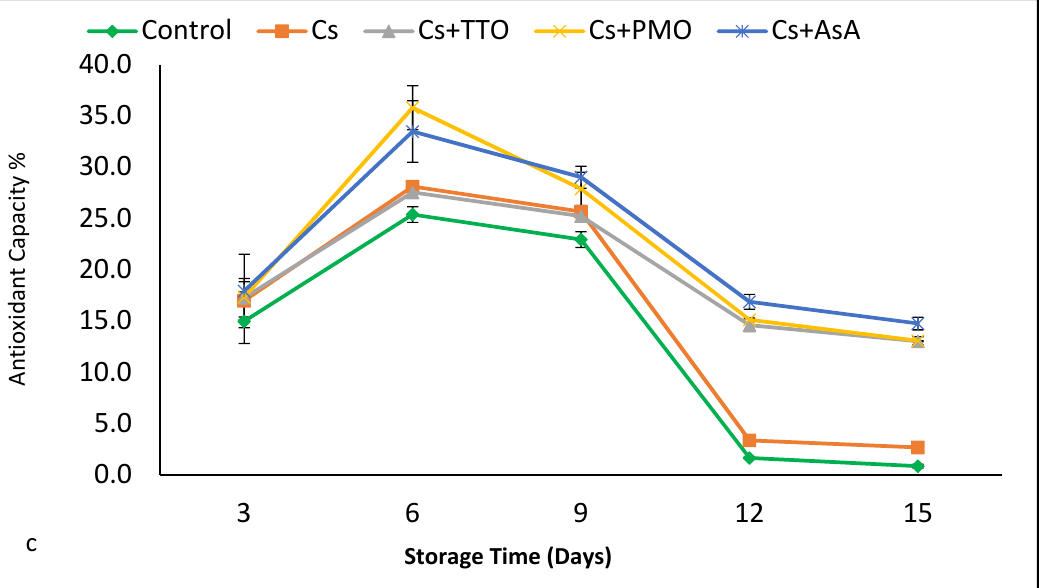
Figure 3. Effect of chitosan (Cs), Cs + tea tree oil (Cs + TTO), Cs + peppermint oil (Cs + PMO), and Cs + ascorbic acid (Cs + AsA) on ( A ) total sugar, ( B ) browning index, and ( C ) antioxidant capacity content of fresh-cut green bean pods stored for 15 d at 5 °C. Error bars = SE, n = 6. Table 1. Effect of chitosan (Cs), Cs + tea tree oil (TTO), Cs + peppermint oil (PMO), and Cs + ascorbic acid (AsA) on mold and yeast and total count (log CFU/g) of fresh-cut green bean pods stored at 5 ◦ C for 15 d. Data are the average of 3 replicates ± standard errors. Different letters indicate significant differences (Tukey test, p <